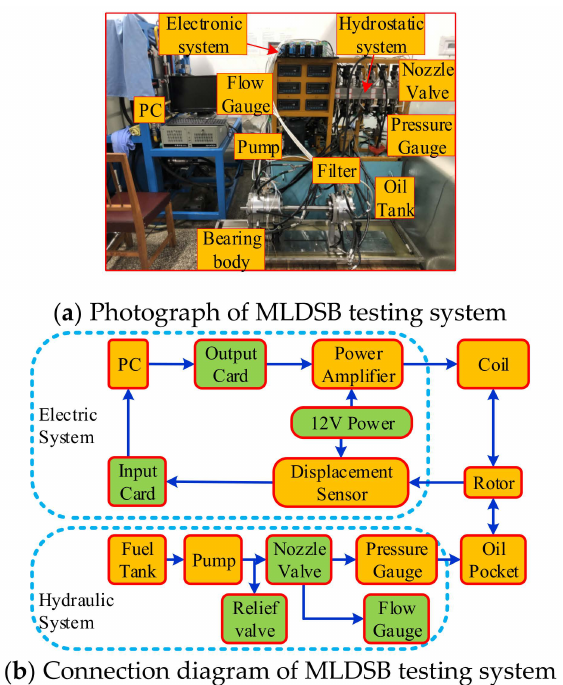
Figure 11. MLDSB testing